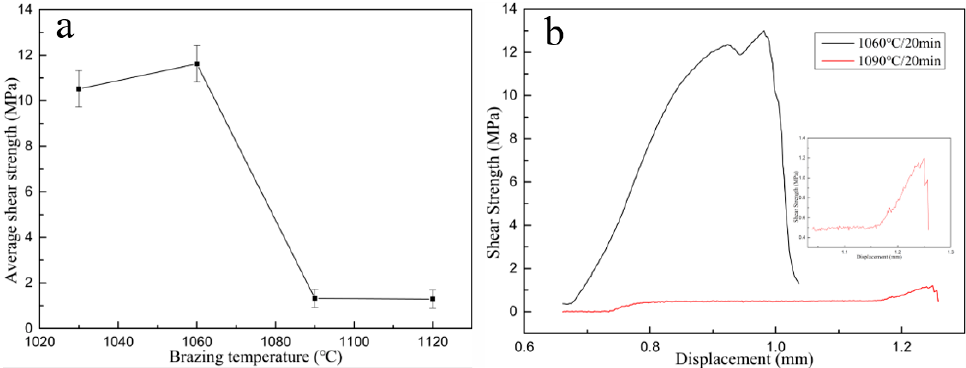
Figure 5. ( a ) Effect of brazing temperature on shear strength, ( b ) Shear strength curve of brazed joint.